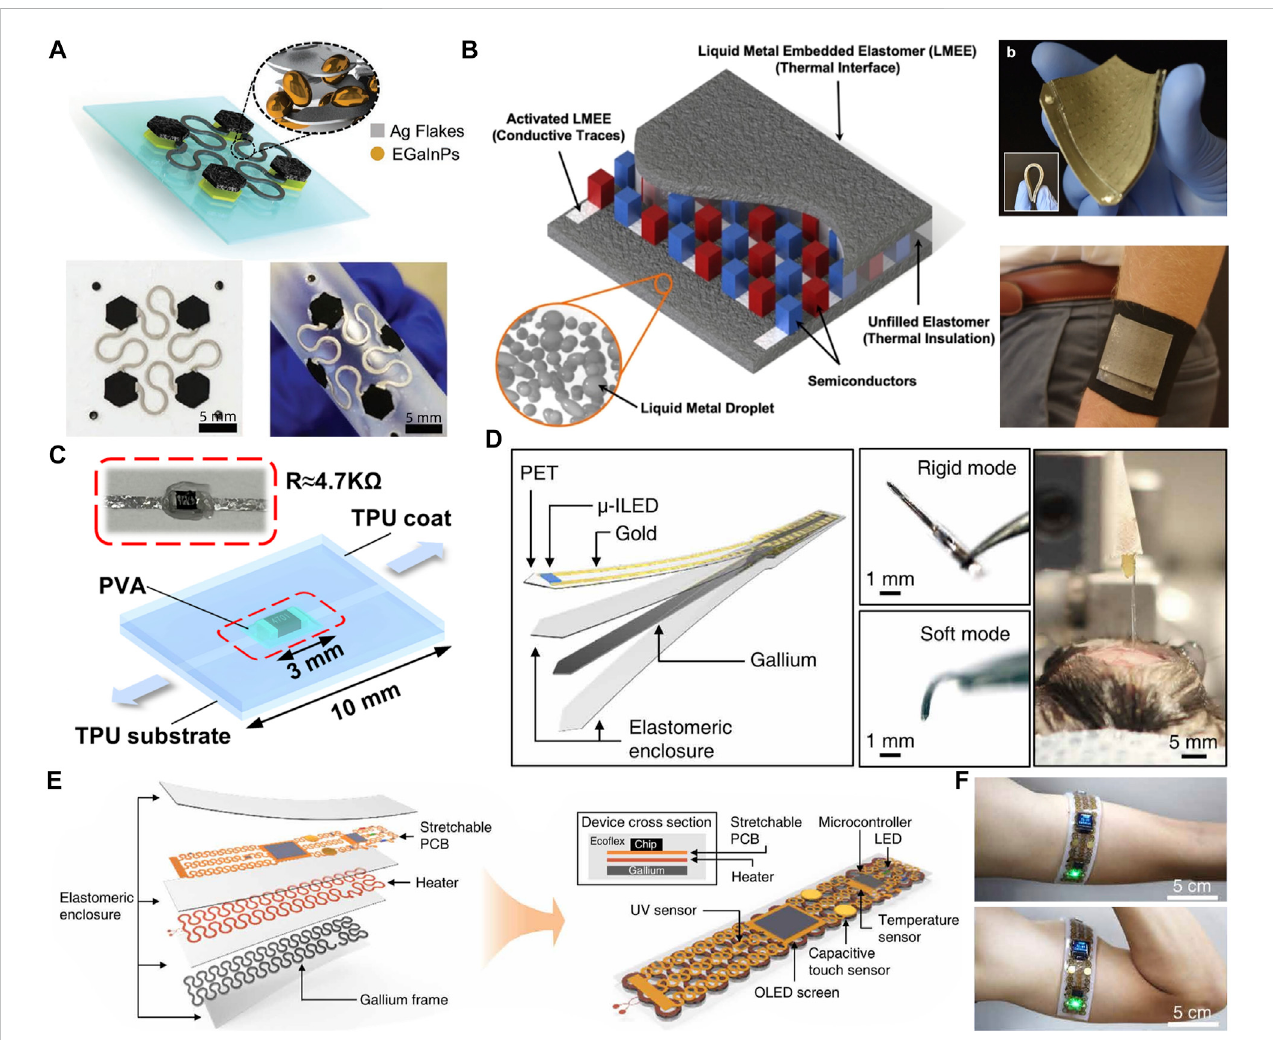
Connecting line with rigid components and fl exible circuit with adjustable stiffness. (A) Layer-by-layer structural illustration of the all-printed Ag-LM-IB structures.(Silvaetal.,2020).Copyright@2020,Wiley (B)